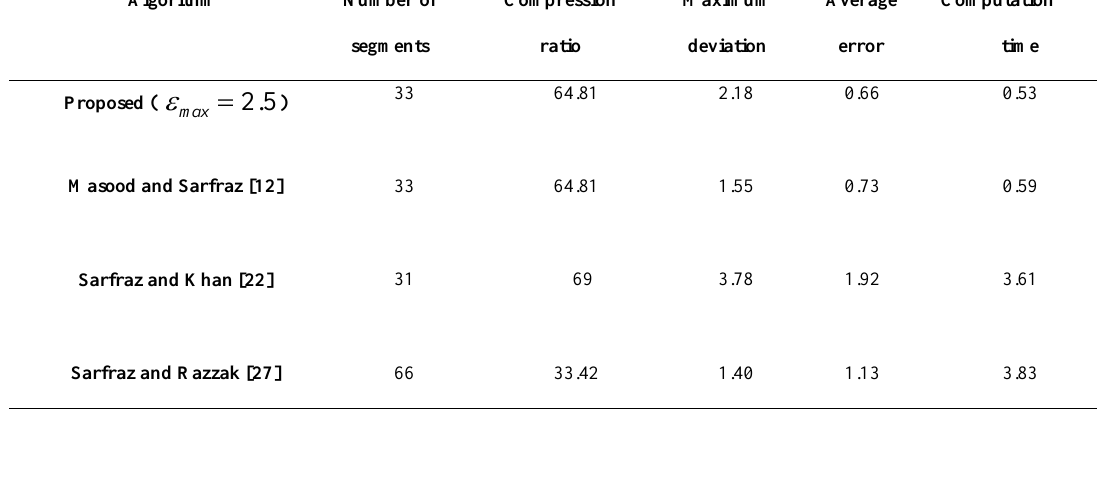
Table 4. Results of quantitative performance with different algorithms for the shape of Kanji character. Algorithm